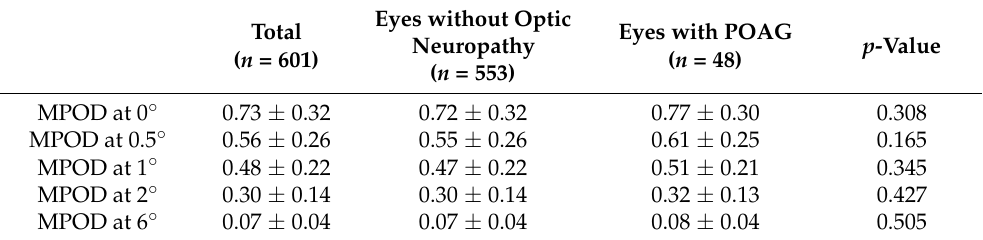
Table 3. Macular pigment optic density at several degree eccentricities from the fovea in control and primary open-angle glaucoma eyes in the Montrachet study.